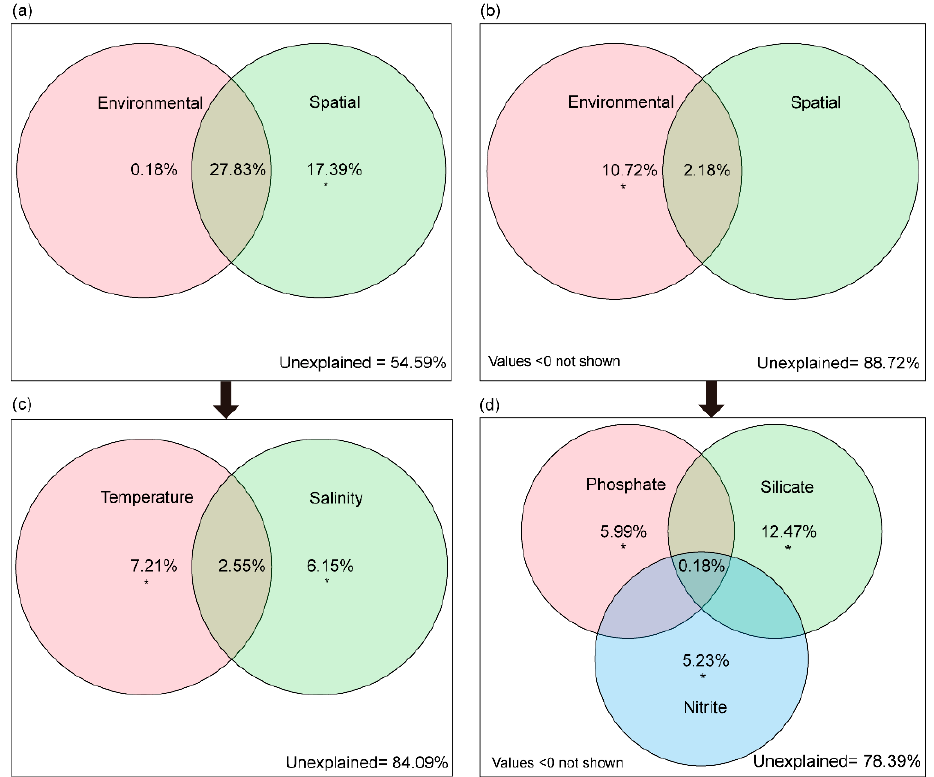
Figure 5. Venn diagrams of variation partitioning analysis showing the effects of spatial and environmental factors on the bacterioplankton communities. The percentage of variation explained by each factor, including unique, shared and unexplained is shown in corresponding positions in the diagram. When no numbers are shown, this matrix had no explanatory wer (zero or negative). Asterisks represent statistical significance: * p < 0.05, as estimated using canonical correspondence analysis. FL community ( a , c ); PA community ( b , d ).